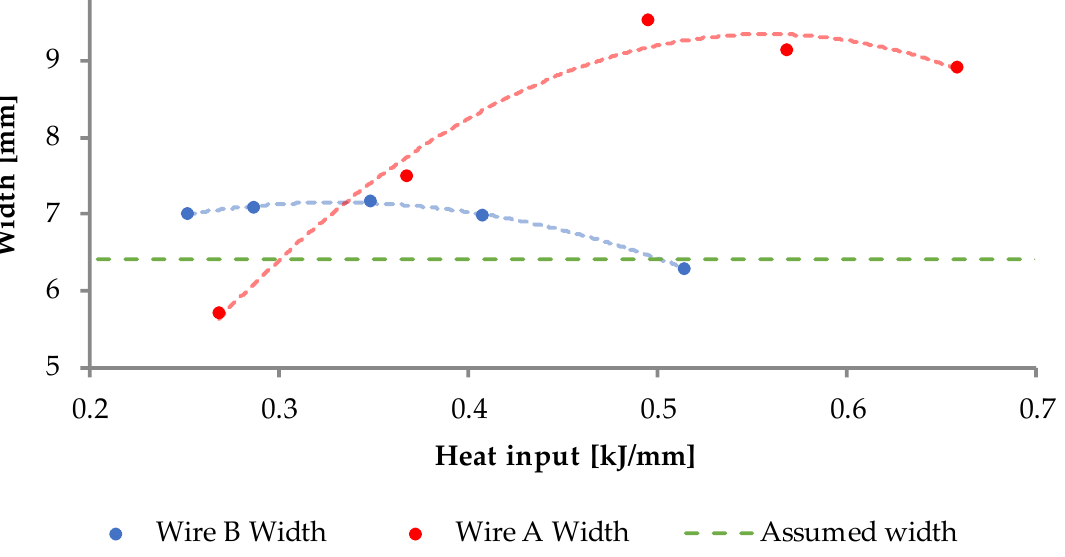
Figure 10. Graph representing the dependence of the weld bead width on the heat input level. The red and blue dashed lines express the second order interpolation, while the green dashed line marks the assumed, target value for the reference.